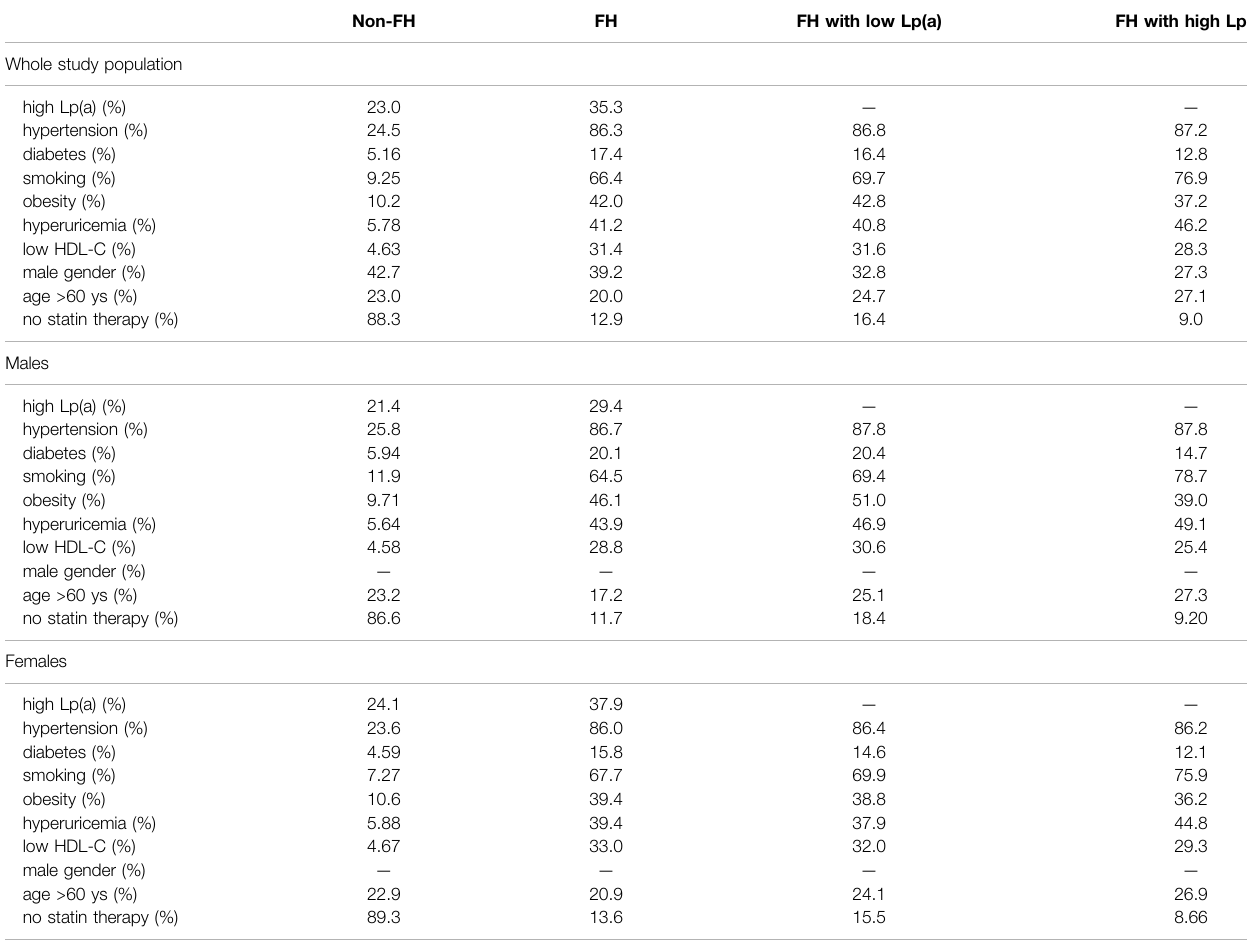
TABLE 3 | Prevalence of cardiovascular risk factors in the whole study population, in FH patients and in FH patients with low and high ( > 500 mg/dl) Lp(a) levels. Non-FH FH FH with low Lp(a) FH with high Lp(a)